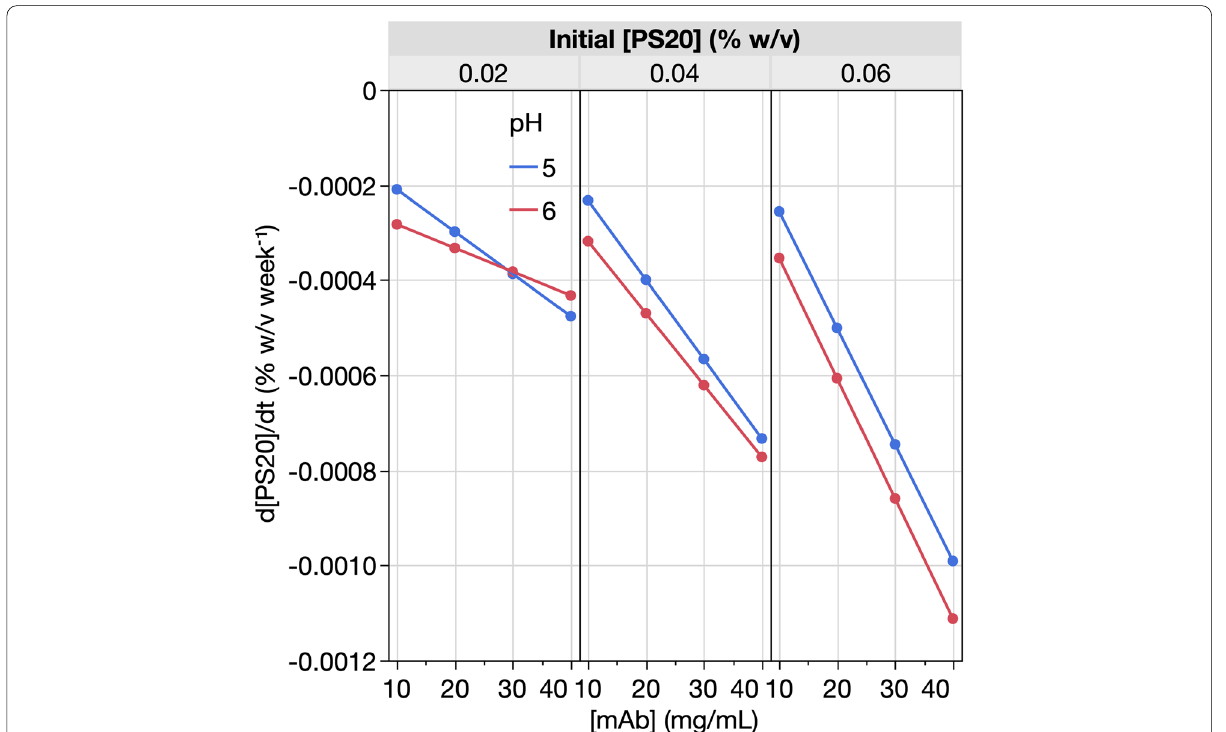
Fig. 7 Rate of change in [PS20] as a function of [mAb] in mAb X DP stored at 5 °C. The 24 formulations (listed in Table 1) represent unique combinations of [mAb], initial [PS20], and pH. Intact [PS20] remaining in each formulation at 12 time points over 24 weeks was quantified by HPLC‑ELSD. The rate of change in PS20 concentration (d[PS20]/dt) was calculated as the derivative from fitting the longitudinal